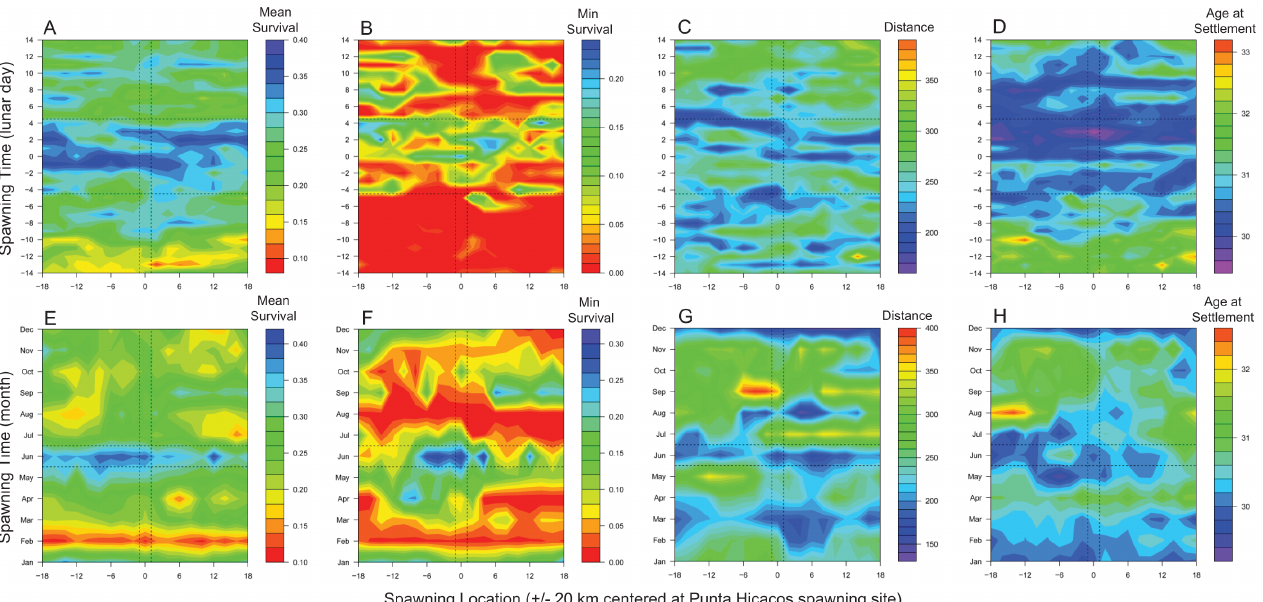
Fig 2. Metrics of larval success for spawning location (x-axis) and spawning time (y-axis). In the top row (A-D), the y-axis represents lunar days within a peak spawning month and, in the bottom row (E-H), the y-axis represents months within a year on the same lunar day. Larval success is measured as (A, E) mean larval survival, (B, F) minimum larval survival, (C, G) mean distance travelled between spawning and settlement, and (D, H) mean larval age at settlement. Color bars are given for each panel, and cool colors are associated with higher fitness (higher survival, shorter distance, younger age). Vertical dashed lines bracket the observed spawning location at Punta Hicacos; horizontal dashed lines bracket the observed spawning period.